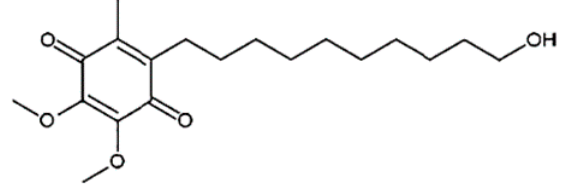
Figure 1. Chemical structure of IDE.